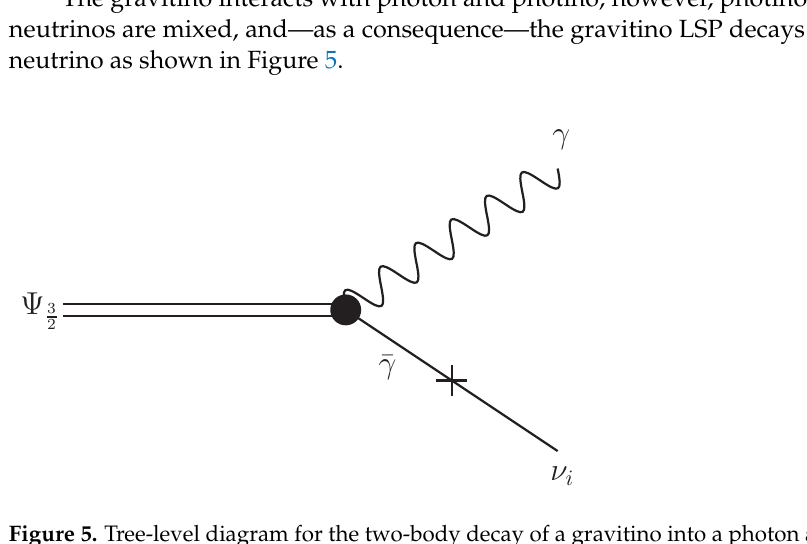
Figure 5. Tree-level diagram for the two-body decay of a gravitino into a photon and a neutrino, via photino-neutrino